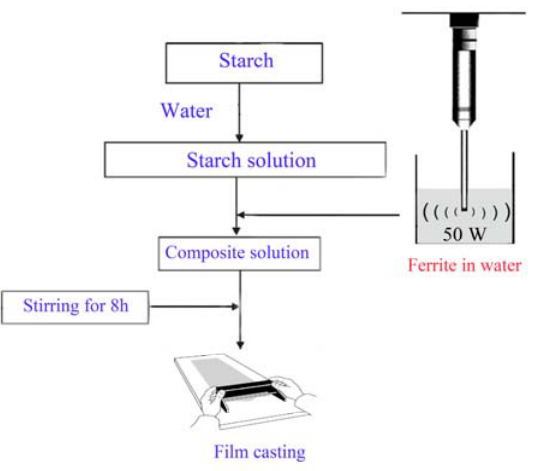
O nanoparticles 2 4